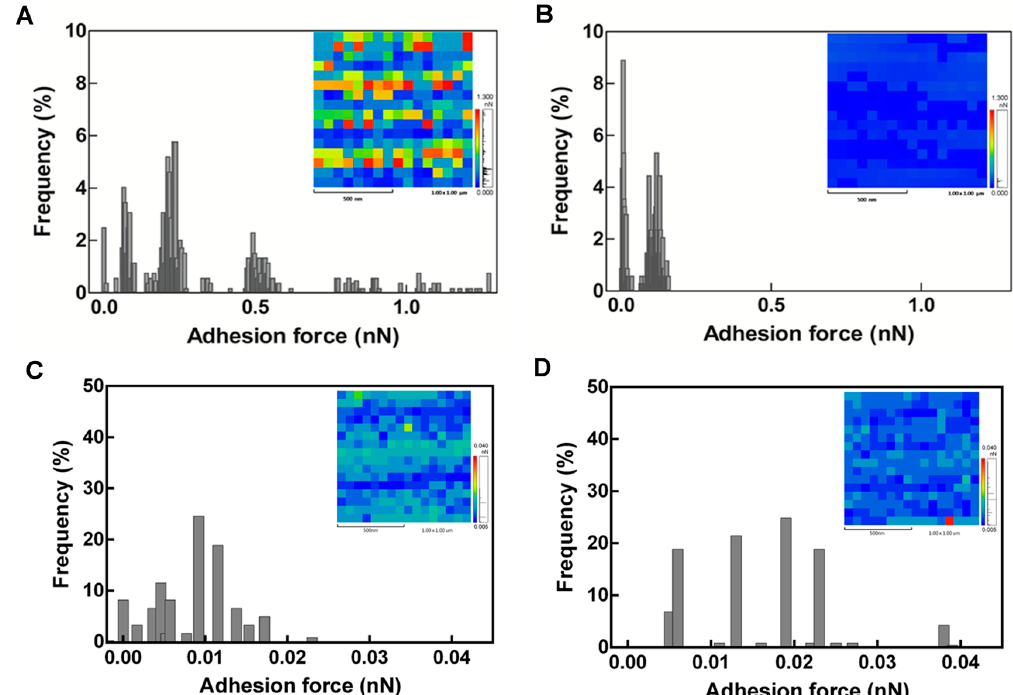
Figure 4. AFM maps and histograms of the adhesion force between the tip and the sample surface of the leaf midribs ( A , B ) and latex ( C , D ) of healthy ( A , C ) and diseased papaya plants ( B , D ). The vertical axis shows the frequency of the adhesion force in a 1000-nm lateral scan of 256 force curves, and the insets are the corresponding force maps.